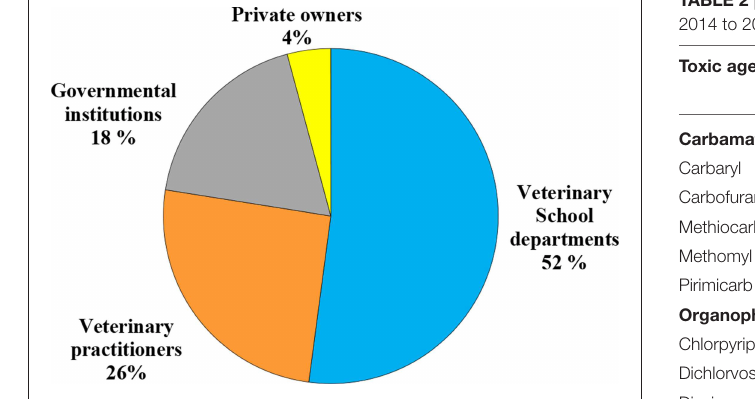
FIGURE 4 | Origin of pesticide analysis requests during 2014–2017.